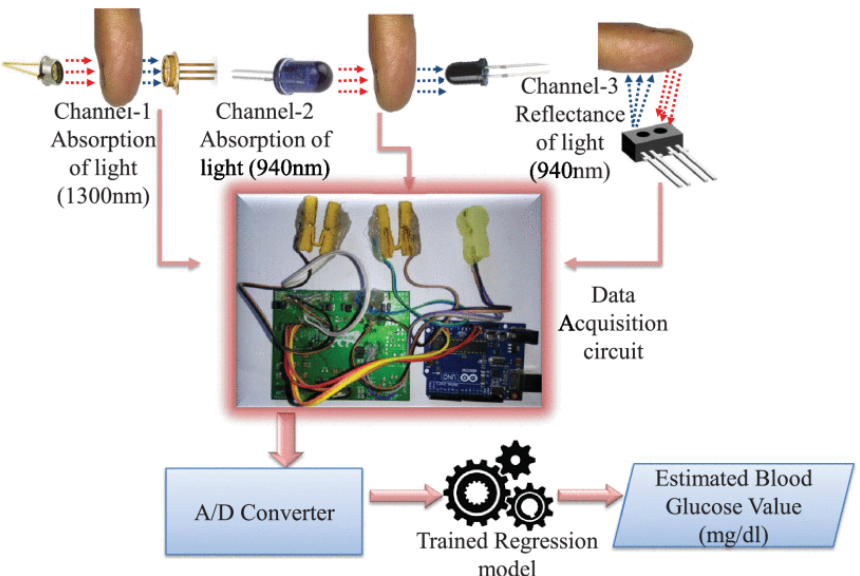
Figure 6. Illustration of the proposed iGLU 2.0 device using dual NIR spectroscopy that involves absorption and reflection spectroscopy of 940 nm, and absorption spectroscopy of 1300 nm. Reprinted with permission from [26].